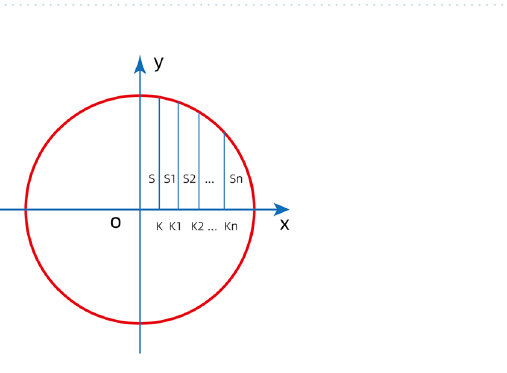
Figure 2. Illustration of the Riemann integral algorithm.